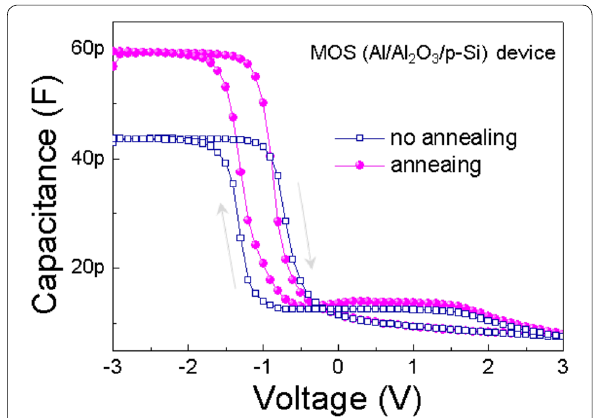
Fig. 3 Comparison of C–V characteristics for non‑annealed and annealed MOS capacitors at 1